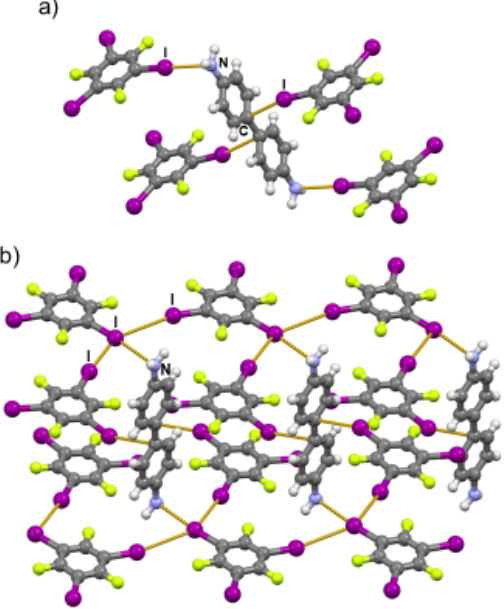
Figure 5. ( a ) Halogen bonding between bnzd and 135tfib molecules in the structure of ( bnzd )( 135tfib ) 4 ; ( b ) a layer formed by linking bnzd and 135tfib molecules via I···NH 2 , I ⋯ C π and I···I halogen bonds in the structure of ( bnzd )( 135tfib ) 4 .